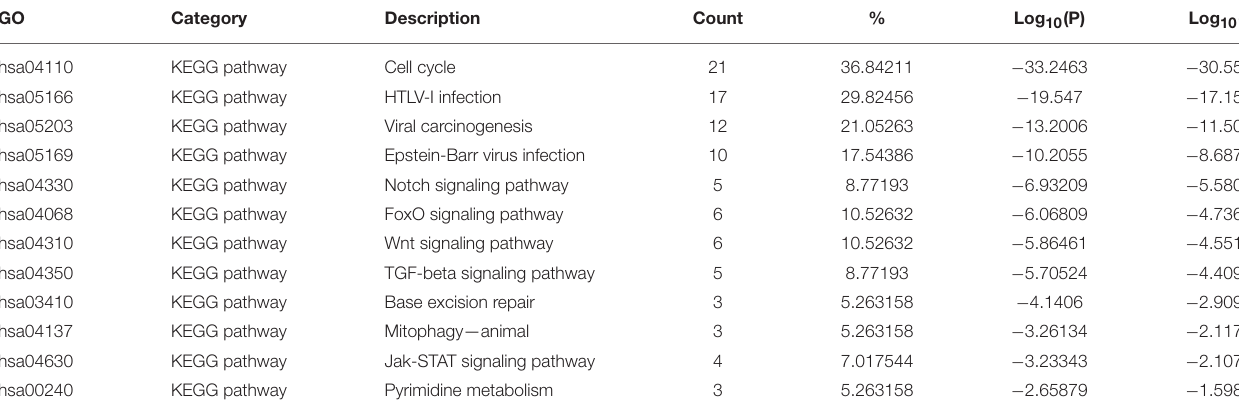
TABLE 3 | The KEGG function enrichment analysis of E2F family members and neighbor genes in OC